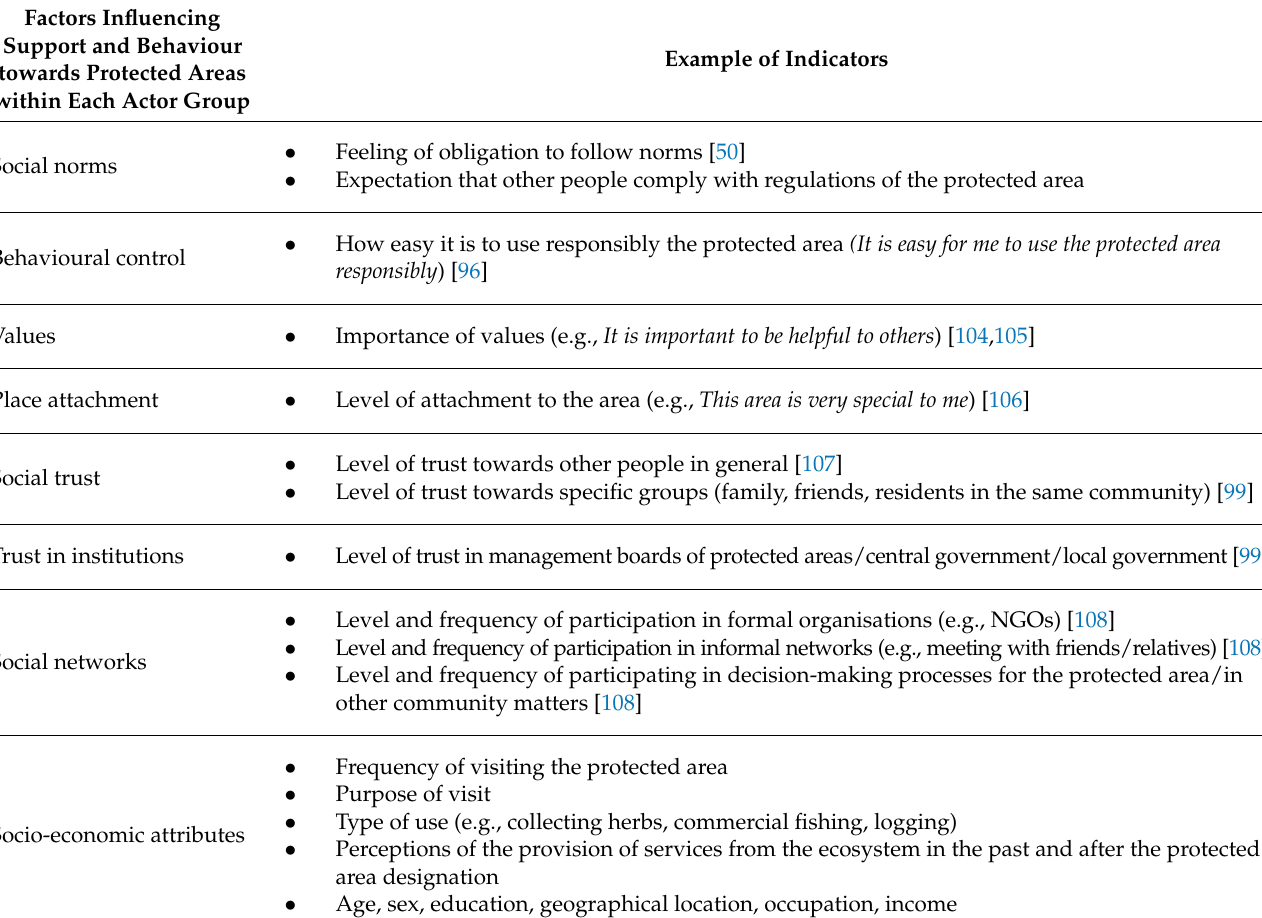
Table 1. Pre-existing factors influencing support for a protected